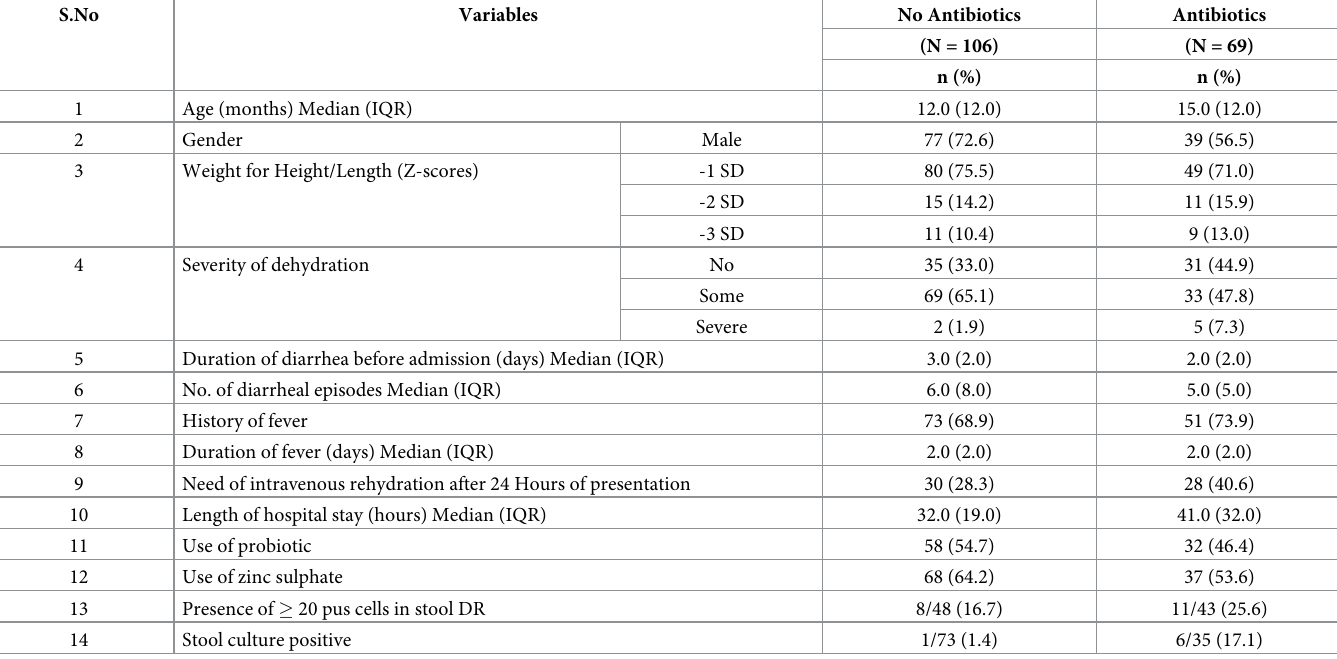
Table 1. Descriptive statistics of children with acute watery diarrhea in a tertiary care hospital,